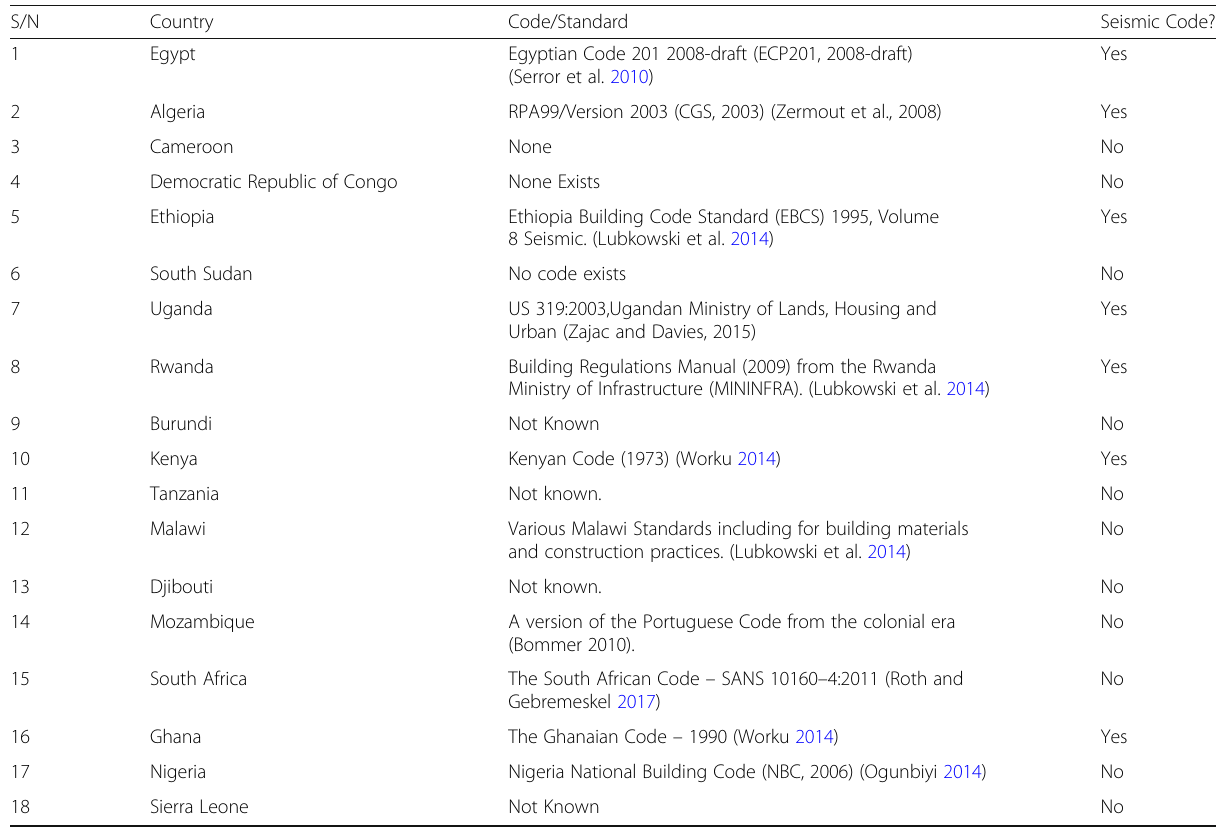
Table 7 Seismic Code and Standards in African Countries which are prone to seismic activities S/N Country